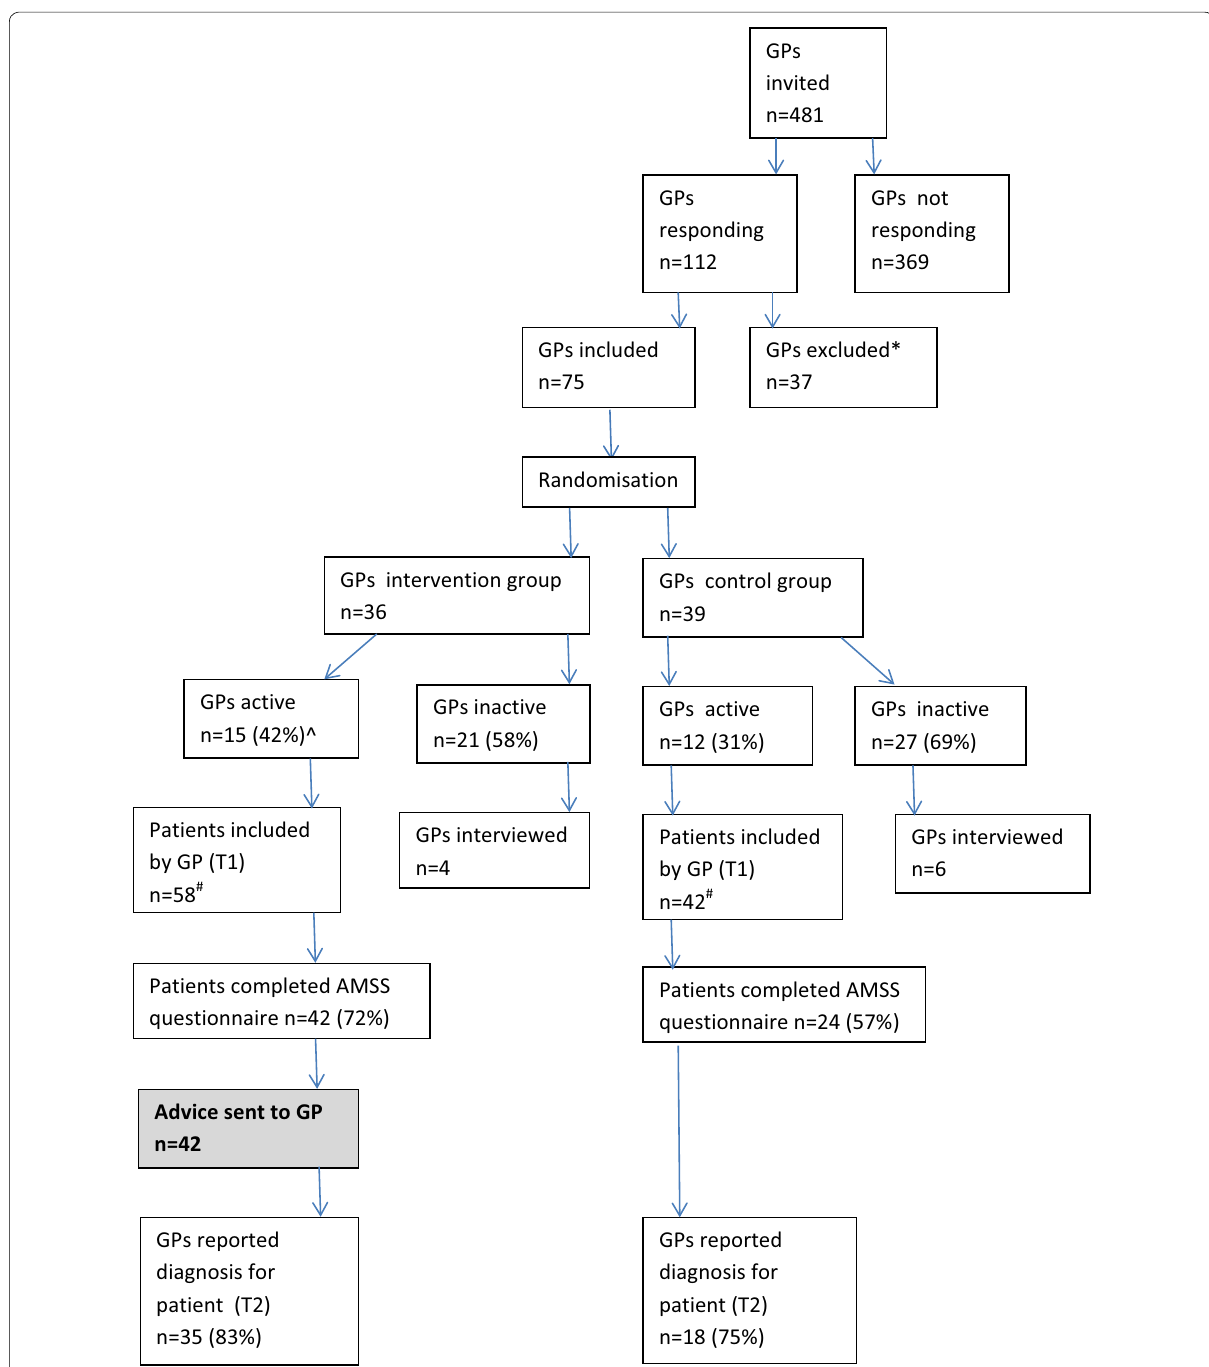
Fig. 2 Flow chart of the pilot study. *GP refused to participate because of being busy/no priority (n moving/changes in practice (n 6), performs sIgE at other laboratory (n = represent those of the previous step in the chart. # In total 101 patients were included by GPs. However, for one patient it was unclear by which GP she was included and thus whether the GP was from the intervention or control group. Also, she did not complete the AMSS questionnaire and was therefore excluded from further